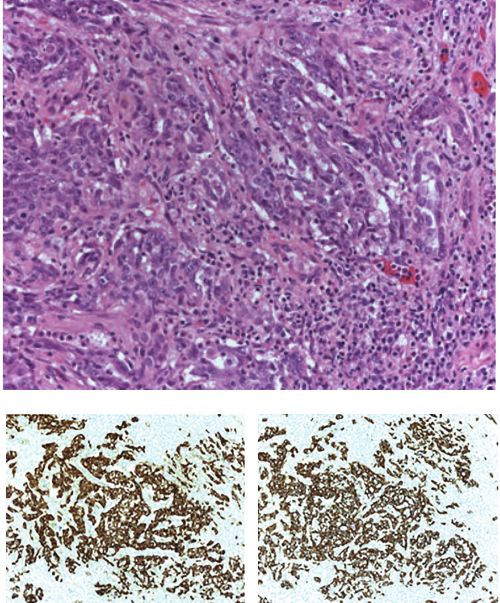
Figure 2: Supraclavicular lymph node (20x) with immunohisto- chemistry for CAM 5.2 and